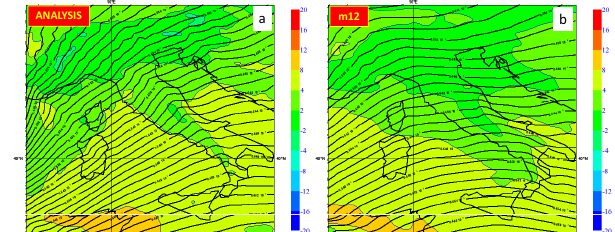
Fig. 9. Geopotential height at 500hPa (gpm, contour lines) and temperature at 850hPa (colour shading) at 18:00UTC, 29 Novem- ber 2008. (a) ECMWF analysis. (b) Forecast fields issued by the ECMWF representative member number 12